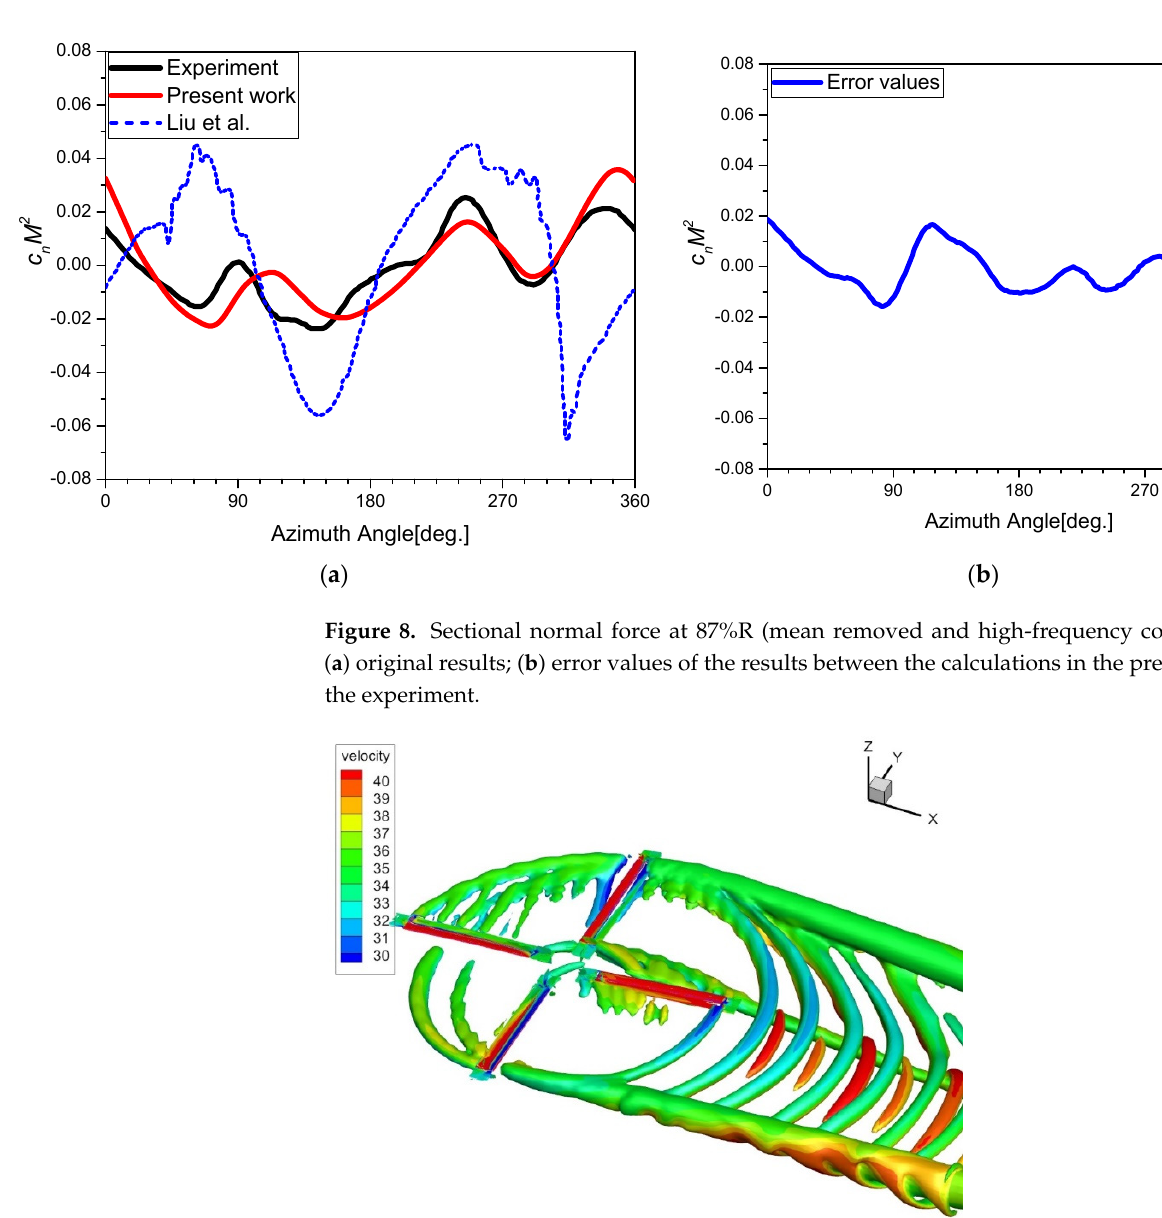
Figure 7. Frequency diagram of the Hart-II model rotor, predicted by the CSD model.